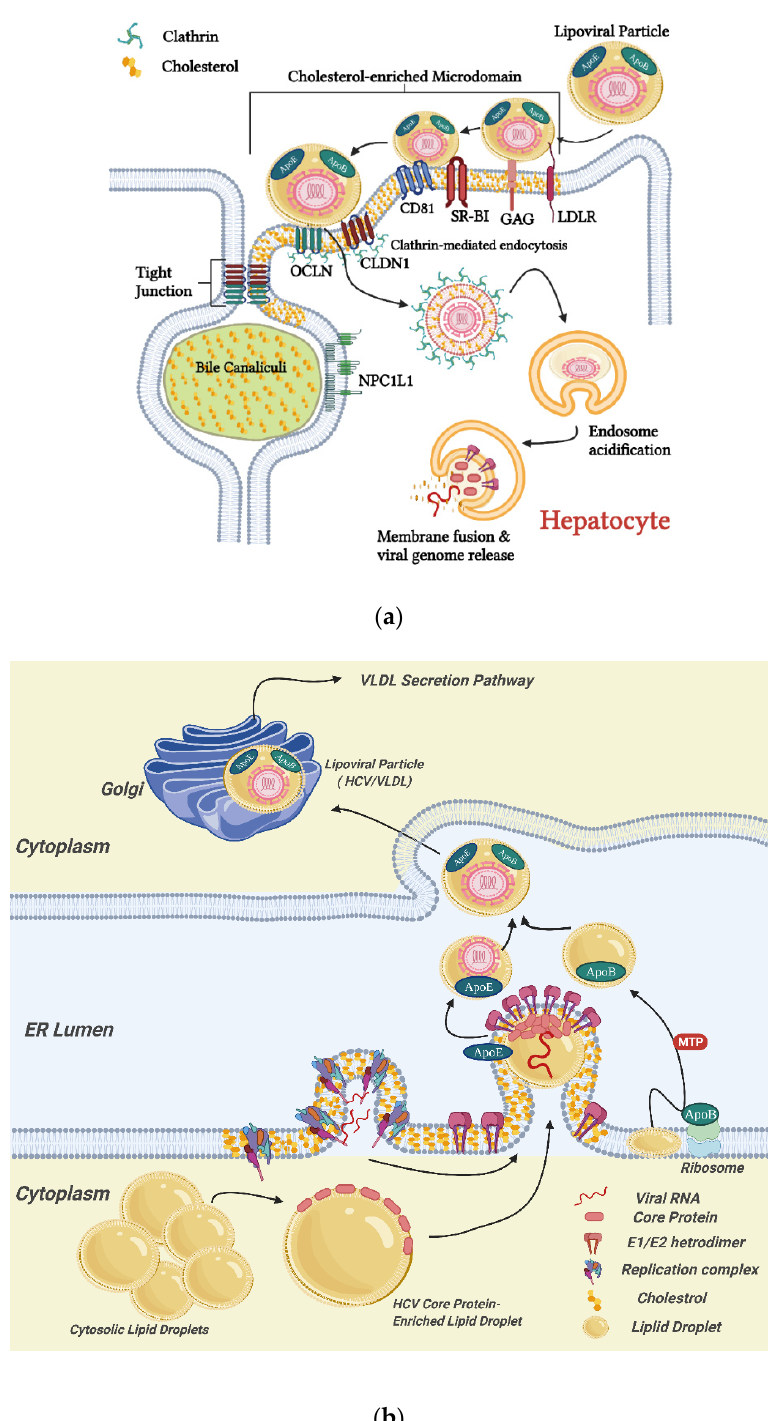
Figure 2. Schematic diagrams of the HCV entry into hepatocyte ( a ) and the replication, assembly, and secretion of HCV ( b ). ( a ) HCV entry into hepatocytes is a sequential process in which multiple factors, including glycosaminoglycan (GAG), low-density lipoprotein receptor (LDLR), scavenger receptor class B type I (SR-BI), CD81, tight junction proteins, claudin-1 (CLDN1), and occludin (OCLN), as well as Niemann–Pick C1-like 1 (NPC1L1), are involved [73,87,88]. The process starts with the binding of the lipoviral particle (LVP) to GAG and LDLR, followed by the interactions with SR-BI, CD81, CLDN1, and OCLN, leading to viral internalization in cholesterol-enriched microdomains (lipid rafts) of the membranes via a clathrin-mediated endocytosis; ( b ) HCV viral proteins induce rearrangement of ER membranes and form replication complexes [15]. Localization